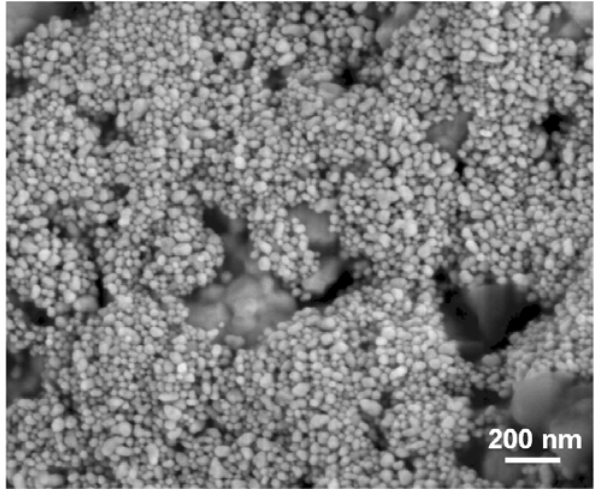
Figure 4. SEM micrograph of thermally annealed Au-NPs. Reprinted with permission from [30].